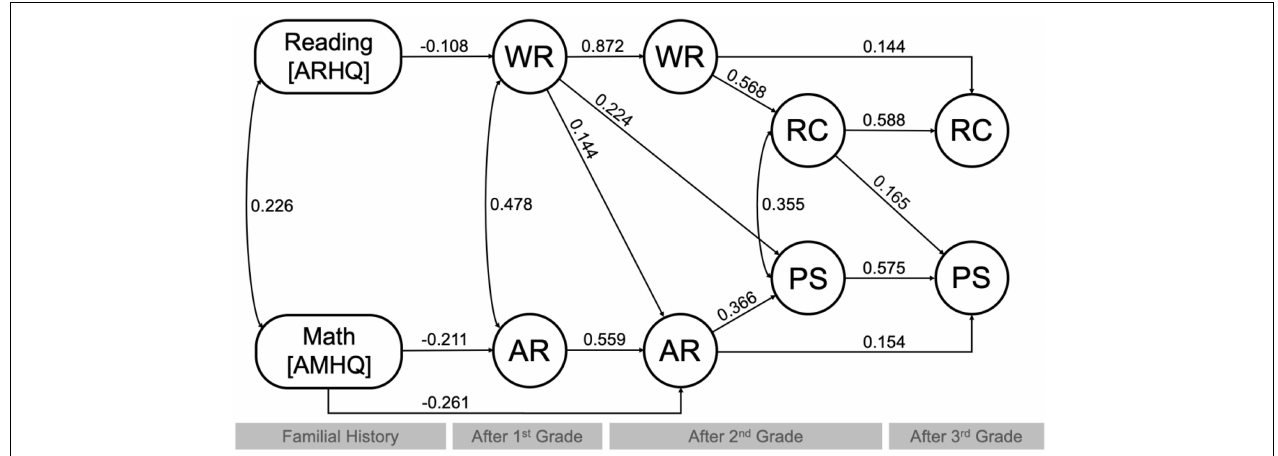
FIGURE 1 | Final path model for the direct and indirect effects of familial history of reading and math difficulties (i.e., indexed by ARHQ and AMHQ, respectively) on measures for children’s core academic skills [word reading (WR) and arithmetic calculation (AR)] after first and second grades, and performance on complex tasks [reading comprehension (RC) and problem solving (PS)] after second and third grades. Parents’ level of educational attainment and children’s demographic information [age, IQ (at baseline), sex, and school information (Title 1 Status)] were included as covariates. (All paths with coefficients shown met p < 0.05).